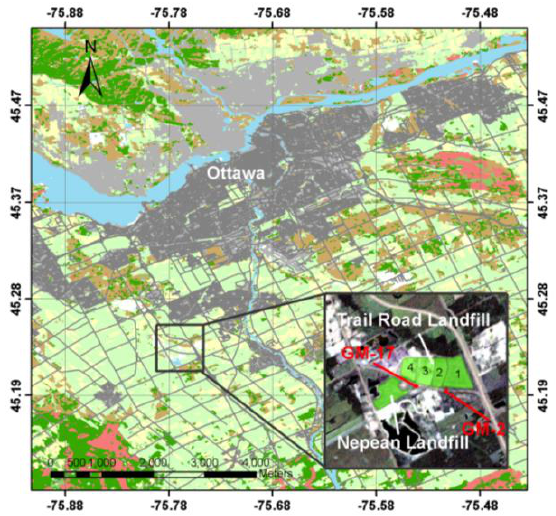
Figure 1. Study area of the Nepean and the Trail Road landfill sites